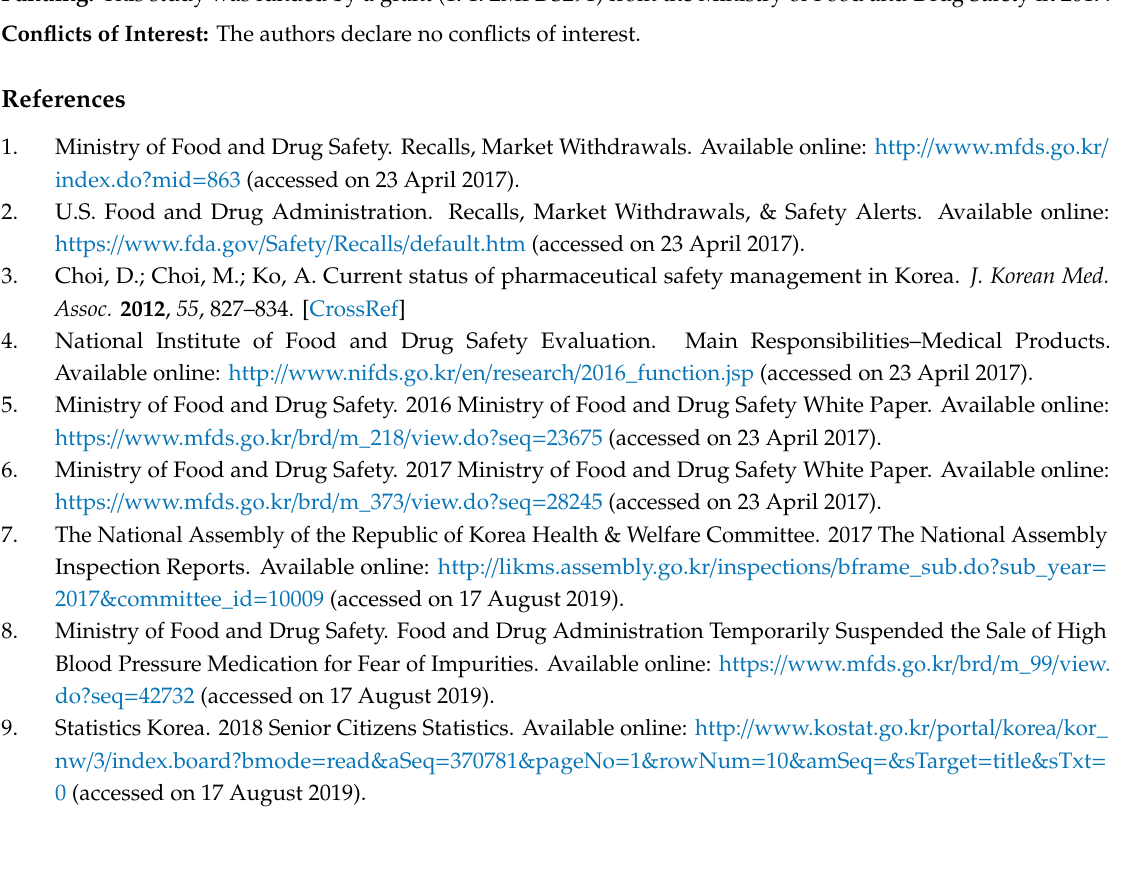
Table S1: Reference future reports; Table S2: Global